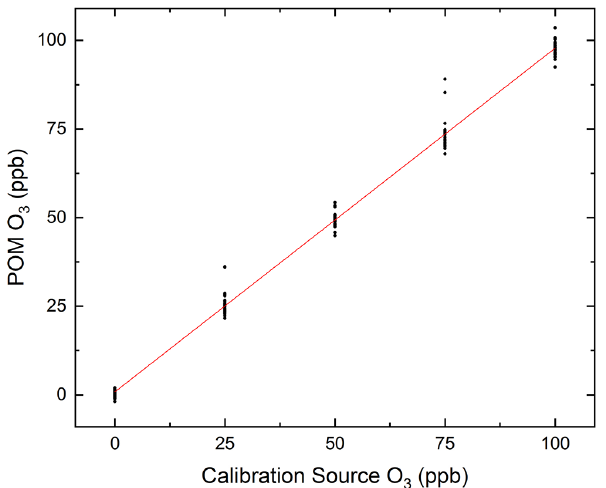
Figure 9. A sample POM calibration from 24 May 2021. The linear regression fit gives y = 0 . 9689 ( ± 0 . 0061) x + 0 . 83 ( ± 0 . 35), R 2 = 0 . 9937. Each calibration concentration had a 5min duration with the POM logging 10s data.